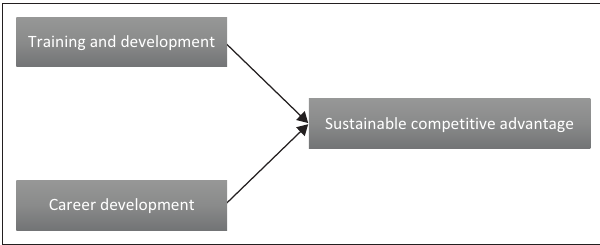
FIGURE 1: Talent development strategies that promote sustainability of higher education